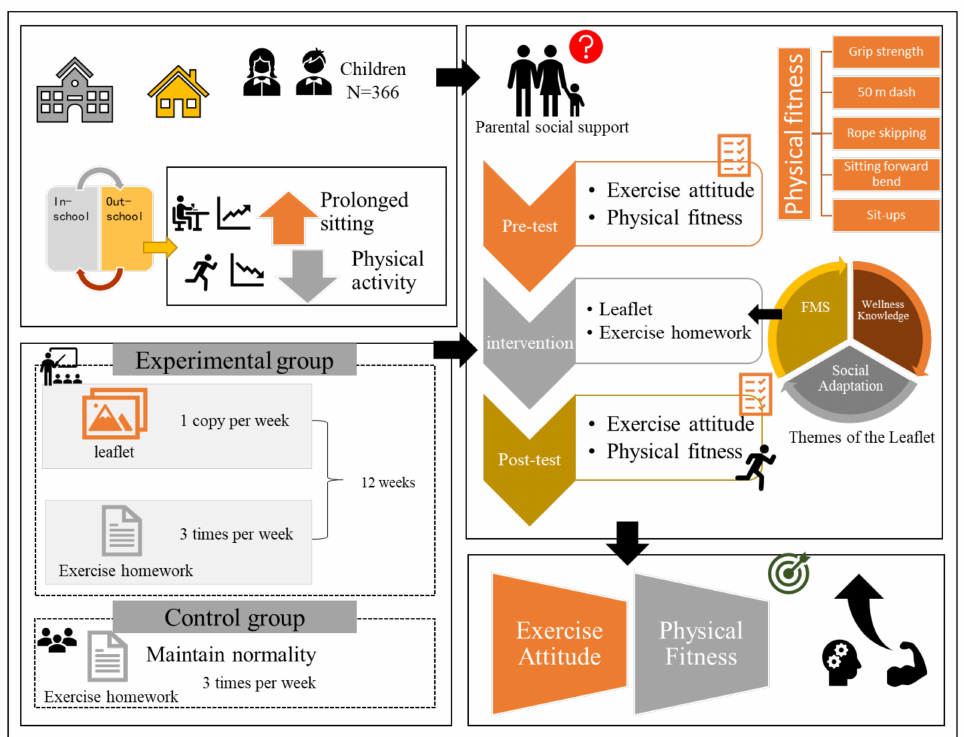
Figure 1. Research design flow chat.